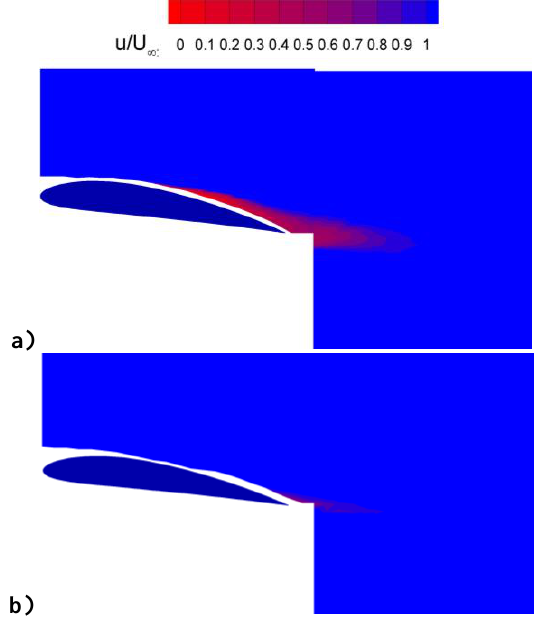
Fig. 6. Velocity measurements results for Re=5x10 4 , α=8º and z/s=0.4 a) uncontrolled case, b) partial flexible